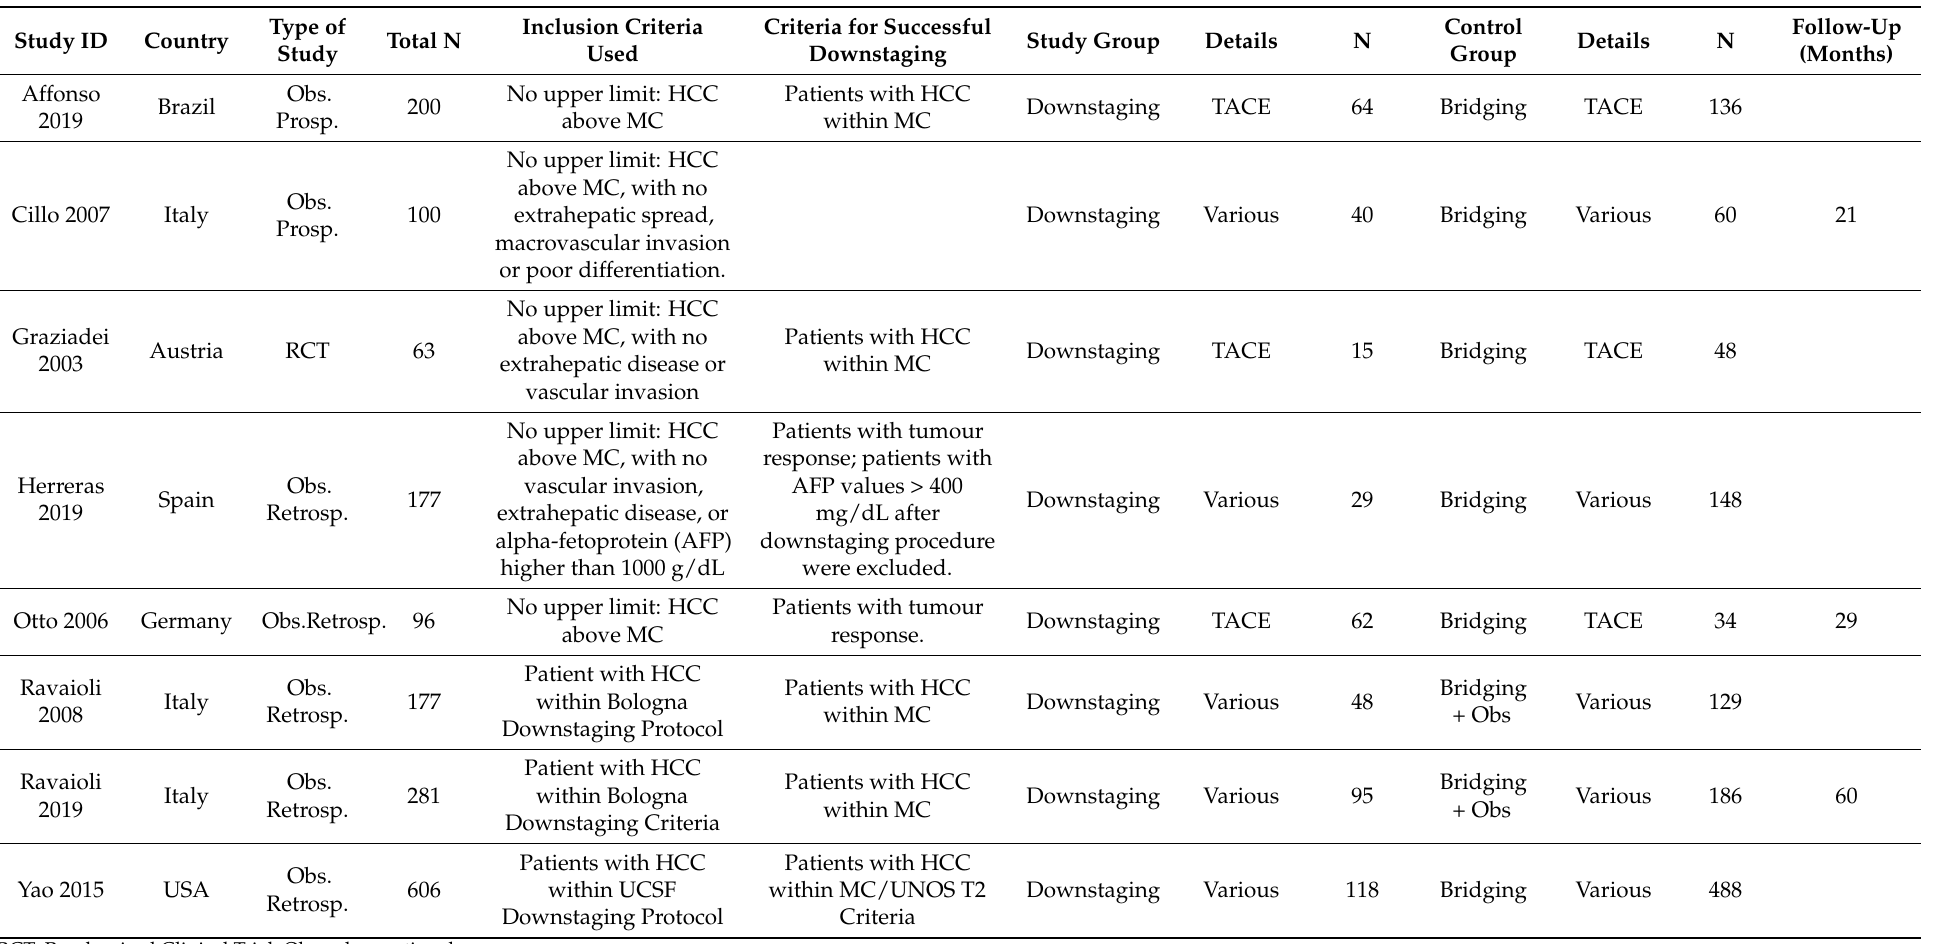
RCT: Randomised Clinical Trial; Obs.: